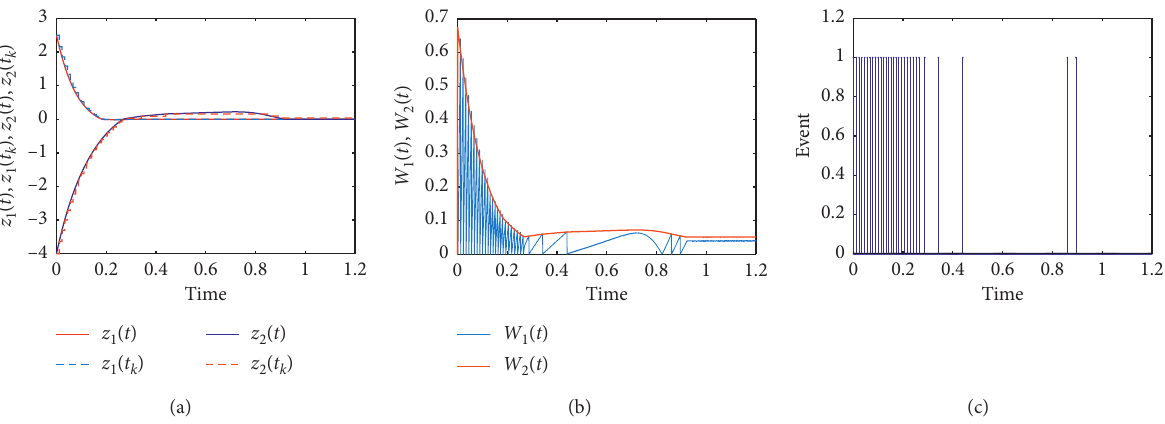
Figure 4: The static event-triggering function (53) with ω � 0 . 75. (a) State trajectories of synchronization error system. (b) Trigger ( t ) � ‖ Δ z ‖ ( t ) � ω ( η − H ‖ z ( t )‖ ) / ( p ) . (c) Event trigger points. parameters W and W 1 1 2 max 1 max